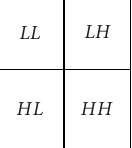
Figure 2: Subbands corresponding to a single-level wavelet decom- position.